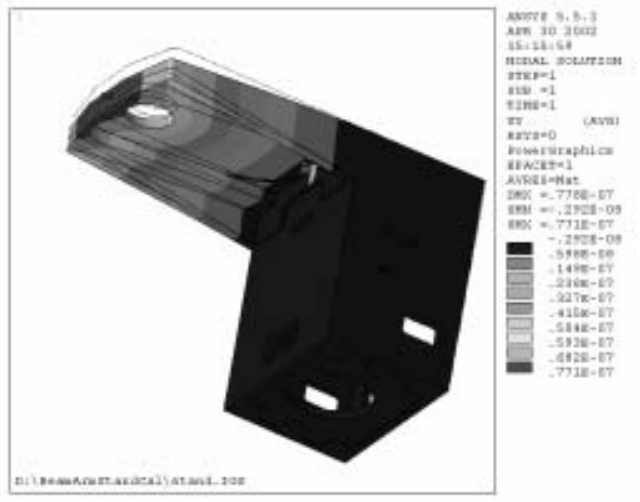
Fig. 20. Bond head stand displacement with 1 N exciting force at point C with big